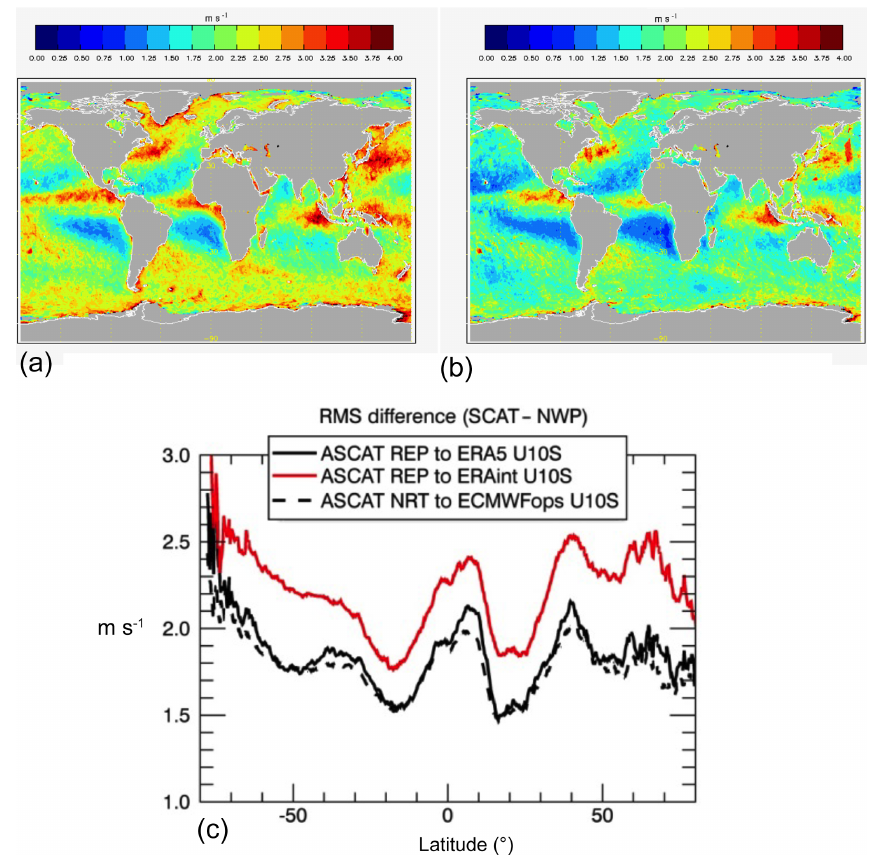
Figure 1. Instantaneous rms wind speed differences between ASCAT observations and ERA-Interim (a) or ERA5 (b) . Panel (c) shows the zonally averaged instantaneous rms curves (ERA-Interim in a red continuous line, ERA5 in a black continuous line and ECMWF operational forecasts in dashed black lines) first-guess winds over 2016.